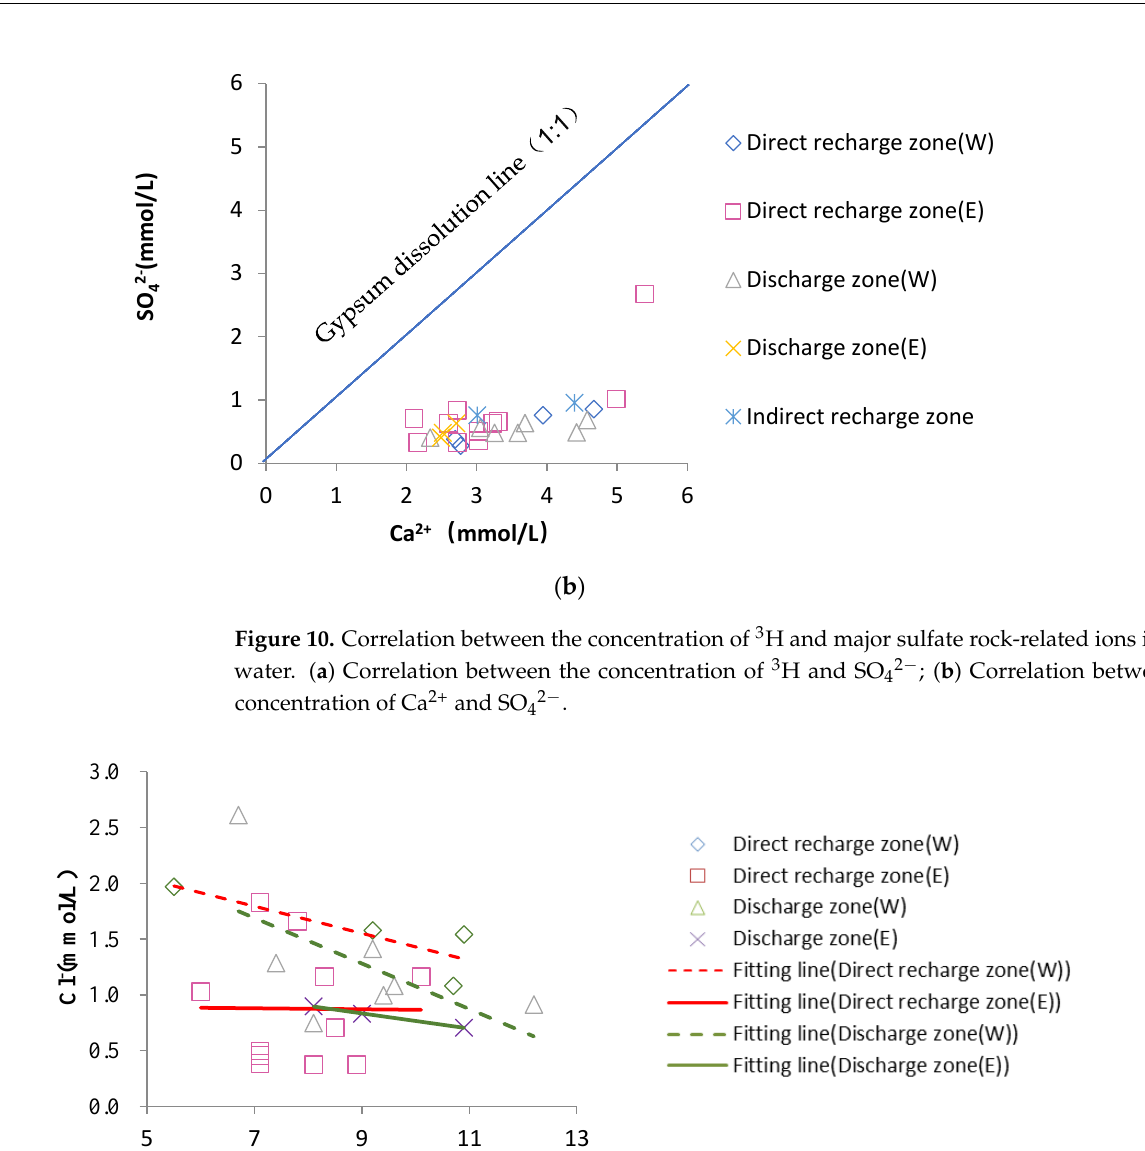
Figure 10. Correlation between the concentration of 3 H and major sulfate rock-related ions in karst water . ( a ) Correlation between the concentration of 3 H and SO 4 2− ; ( b ) Correlation between the concentration of Ca 2+ and SO 4 2− .